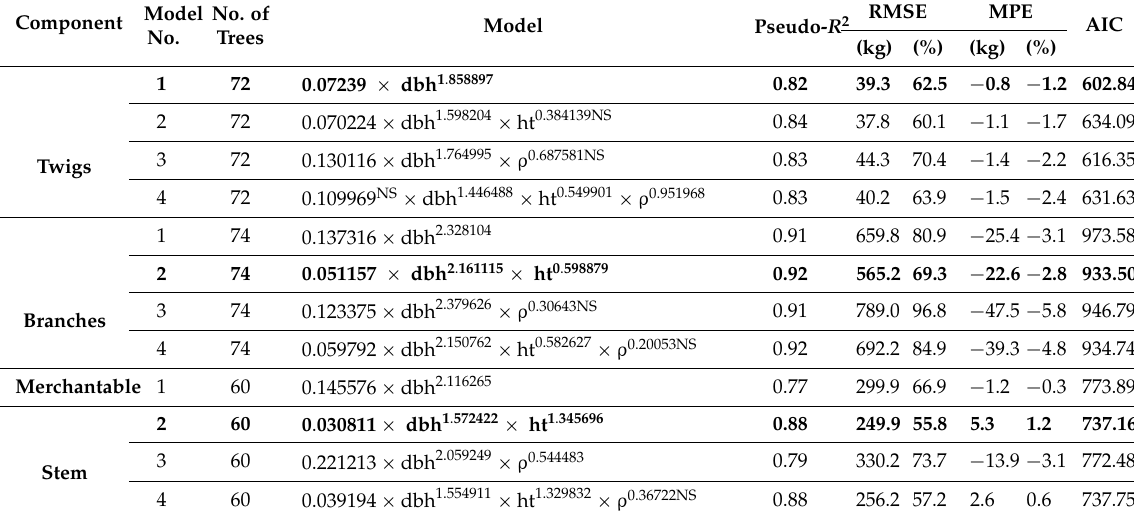
Table 6. Model and performance criteria for twigs, branches and merchantable stem biomass models. Component Model No.